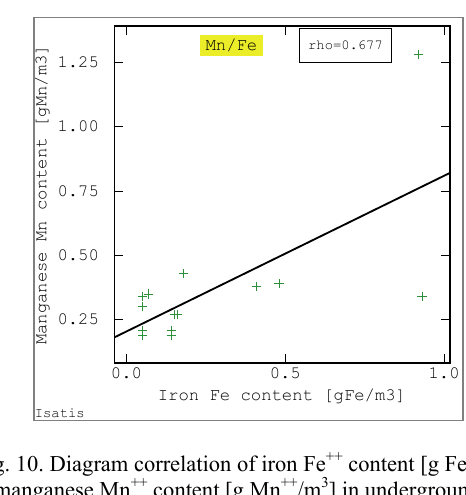
Fig. 10. Diagram correlation of iron Fe ++ content [g Fe ++ /m 3 ] and manganese Mn ++ content [g Mn ++ /m 3 ] in underground water, with the marked regression line Y / X in the area of water intake in the region of Kłodzko (14